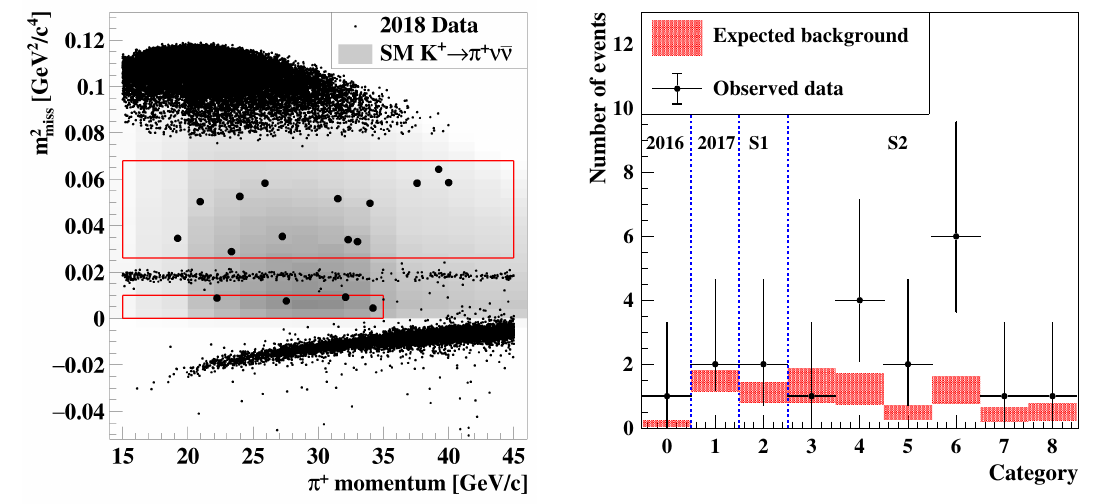
Figure 7 . The K + → π + ν ¯ ν candidate events in the 2018 (left) and 2016–2018 (right) data sets. Left: reconstructed m 2 as a function of π + momentum for events satisfying the K + → miss π + ν ¯ ν selection criteria. The intensity of the grey shaded area reflects the variation of the SM signal acceptance in the plane. The two boxes represent the signal regions. The events observed in Regions 1 and 2 are shown together with the events found in the background and control regions. Right: expected numbers of background events and numbers of observed events in the nine categories used in the maximum likelihood fit to extract the K + → π + ν ¯ ν branching ratio. Categories 0,1 and 2 correspond to 2016, 2017 and S1 subsets, respectively. Categories 3 to 8 correspond to the six 5 GeV /c wide momentum bins of the S2 subset. The observed data for each category are indicated by black markers with Poissonian statistical errors. The shaded boxes show the numbers of expected background events and the corresponding